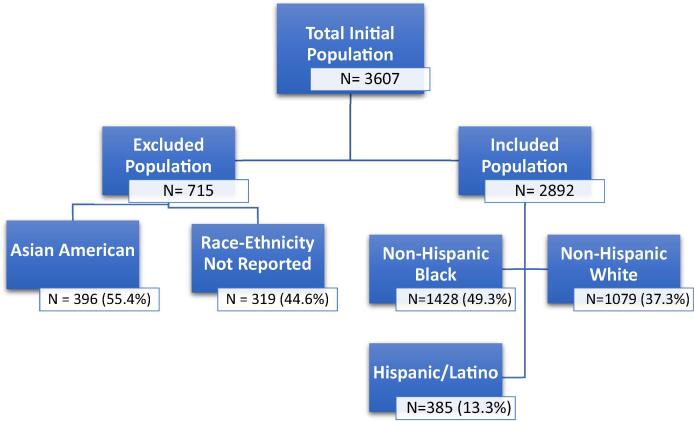
A flow diagram illustrating the recruitment of a multi-ethnic cohort.